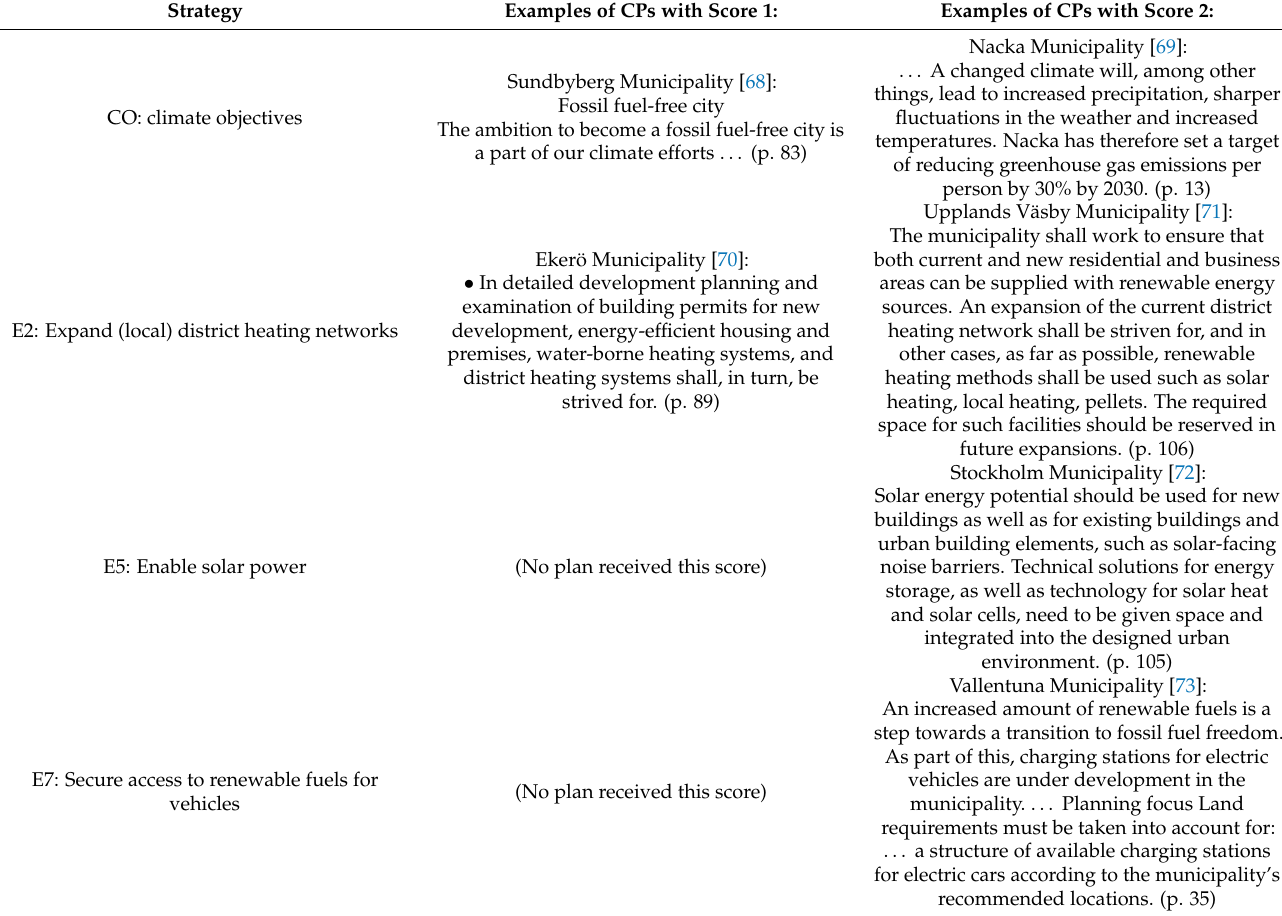
Table A2. Examples of identified strategies in the studied Comprehensive Plans (First author’s